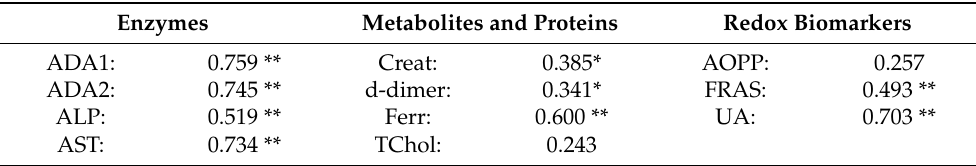
Table 2. Spearman correlation coefficients obtained between ESGD score and the salivary biomarkers. Animals from the ESGD group ( n = 31) and the healthy group ( n = 12) were included in this study. Statistical analysis: *: p < 0.05; **: p <